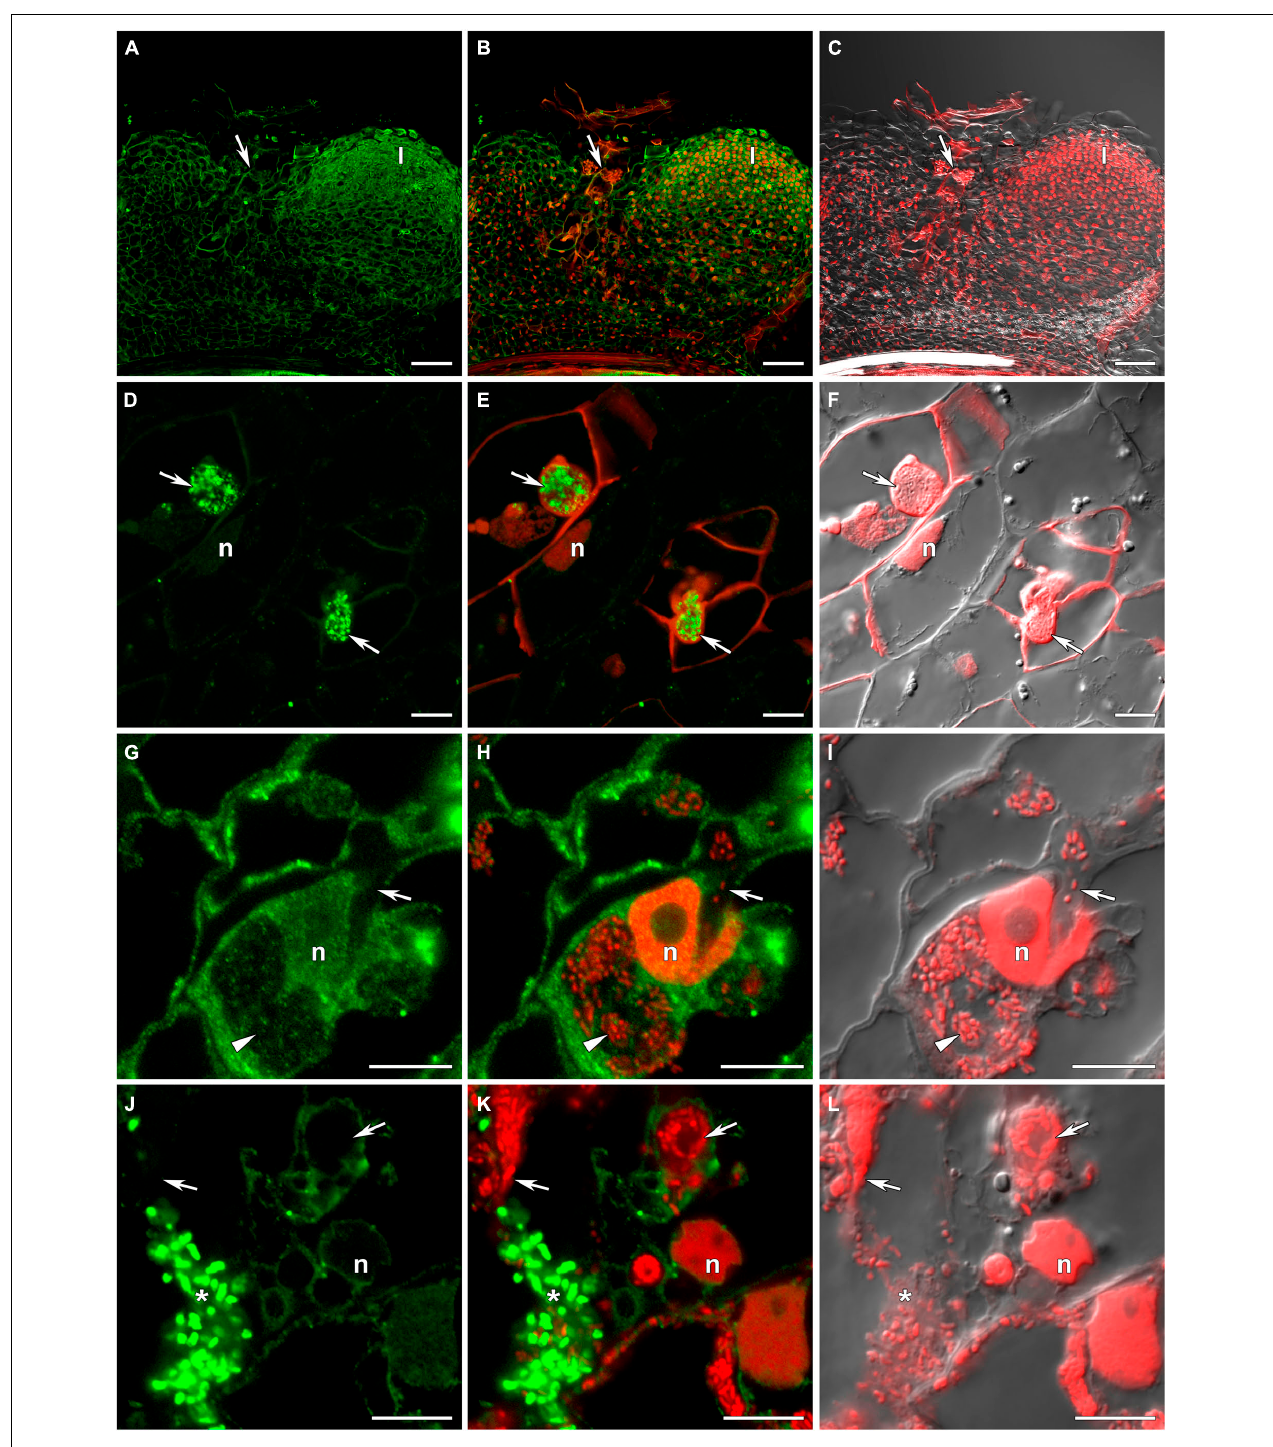
FIGURE 3 | Immunolocalization of glutathione in 3-week-old nodules of the pea ( Pisum sativum ) sym33-3 mutant using a rabbit anti-glutathione (reduced) antibody. (A–C) General view; (D–F) “locked” infection threads; (G–I) infected cells; (J–L) cells with released bacteria. (A,D,G,J) Green channel; (B,E,H,K) merge of the green and red channels; (C,F,I,L) merge of differential interference contrast and the red channel. Confocal laser scanning microscopy images of 50- µ m-thick longitudinal sections. A single optical section is presented, glutathione in green and DNA (bacteria and nuclei) in red. I, meristematic zone; n, nucleus; *, released bacteria. Arrows indicate infection threads; arrowheads indicate infection droplets. Scale bars = 100 µ m (A–C) and 10 µ m (D–L) .